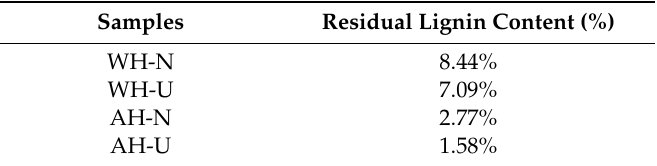
Table 4. The content of residual lignin.